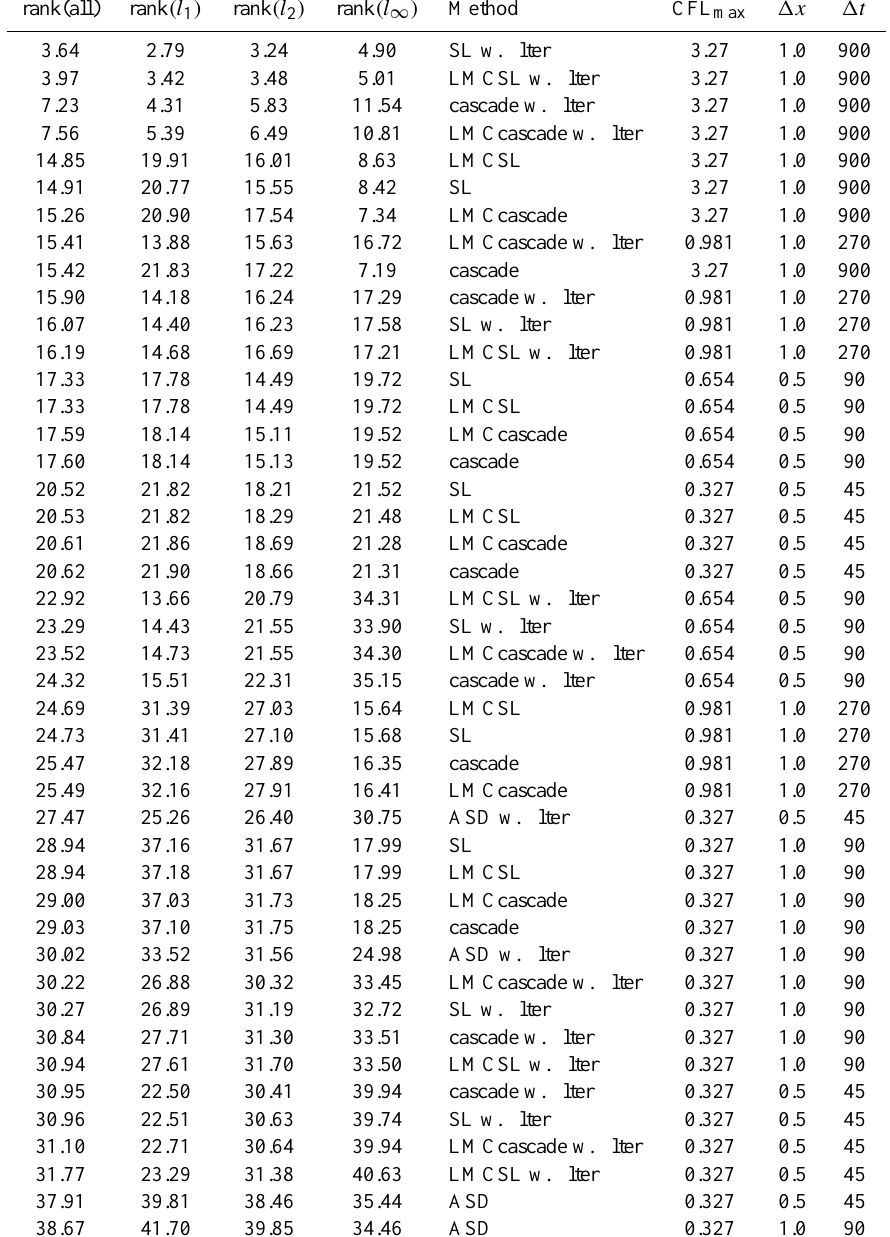
Table 4. Ranking results for the slotted cylinder with urban chemistry. Showing rank of the ranked error measures, rank of error measure l 1 , l 2 , and l ∞ followed by method, maximum Courant number, grid resolution, and time